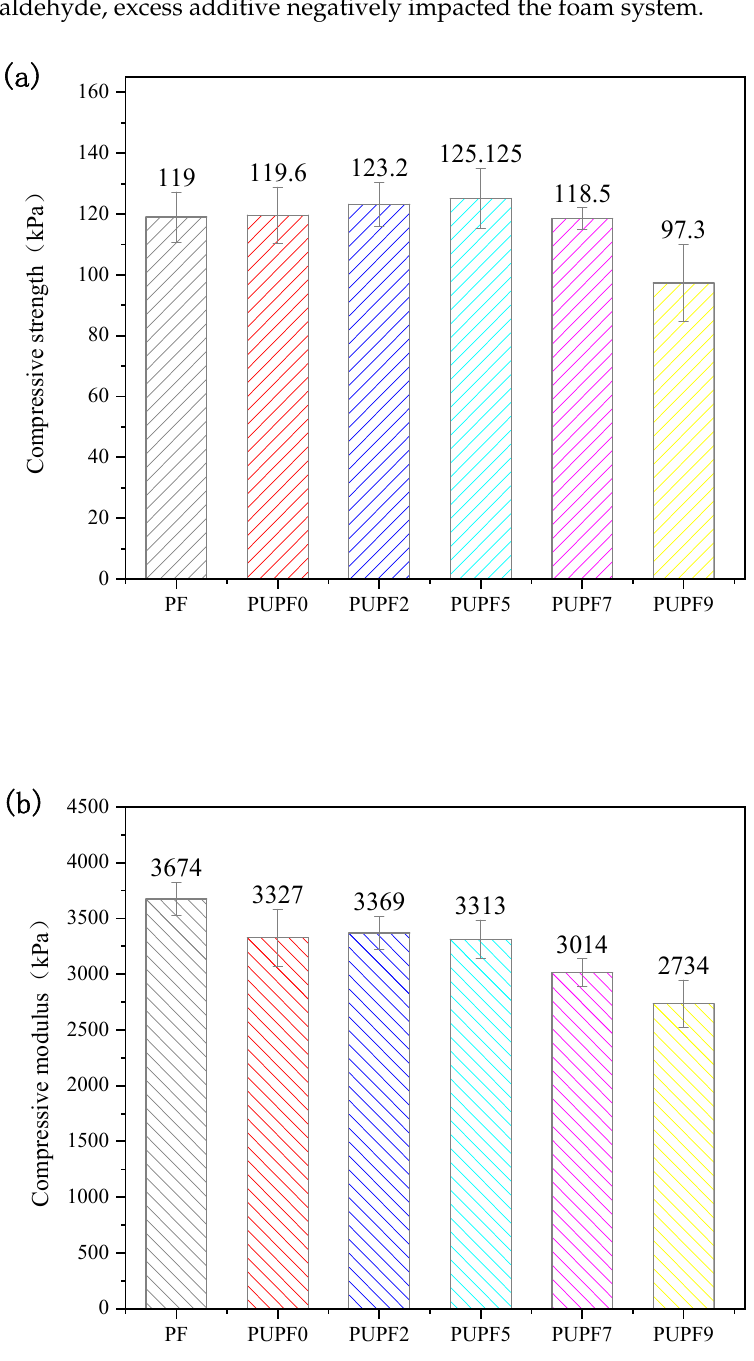
Figure 6. ( a ) Compressive strength and ( b ) compressive modulus of PF and Figure 6. (a) Compressive strength and (b) compressive modulus of PF and PUPFs.